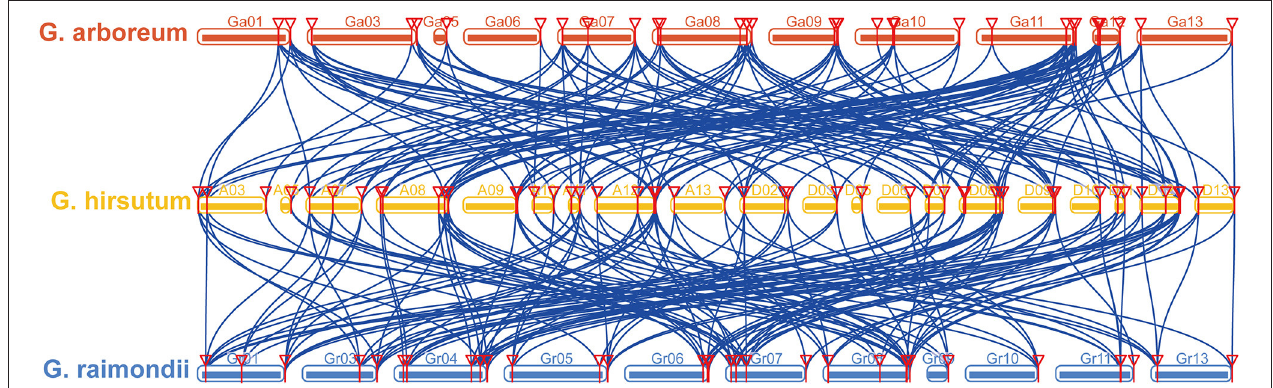
FIGURE 2 | Multiple collinearity analysis of cotton ethylene response function (ERF) subfamily B3 group genes. Multiple collinearity analysis found collinearity blocks among G. arboretum (red), G. hirsutum (yellow), and G. raimondii